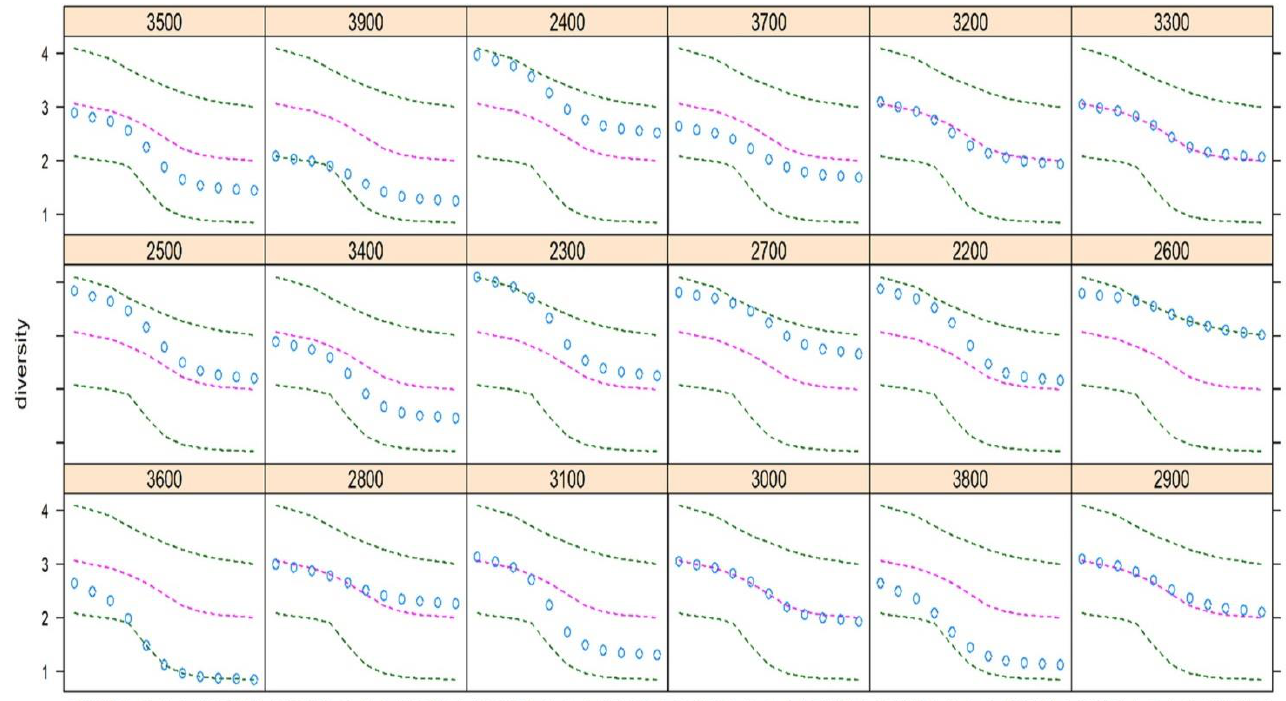
Figure 3. Renyi diversity profiles of total plant species in the studied elevation belts. The dots represent the diversity value for each elevation belt; the outer two dashed lines, the extremes; and the inner pink line, the median in the data.